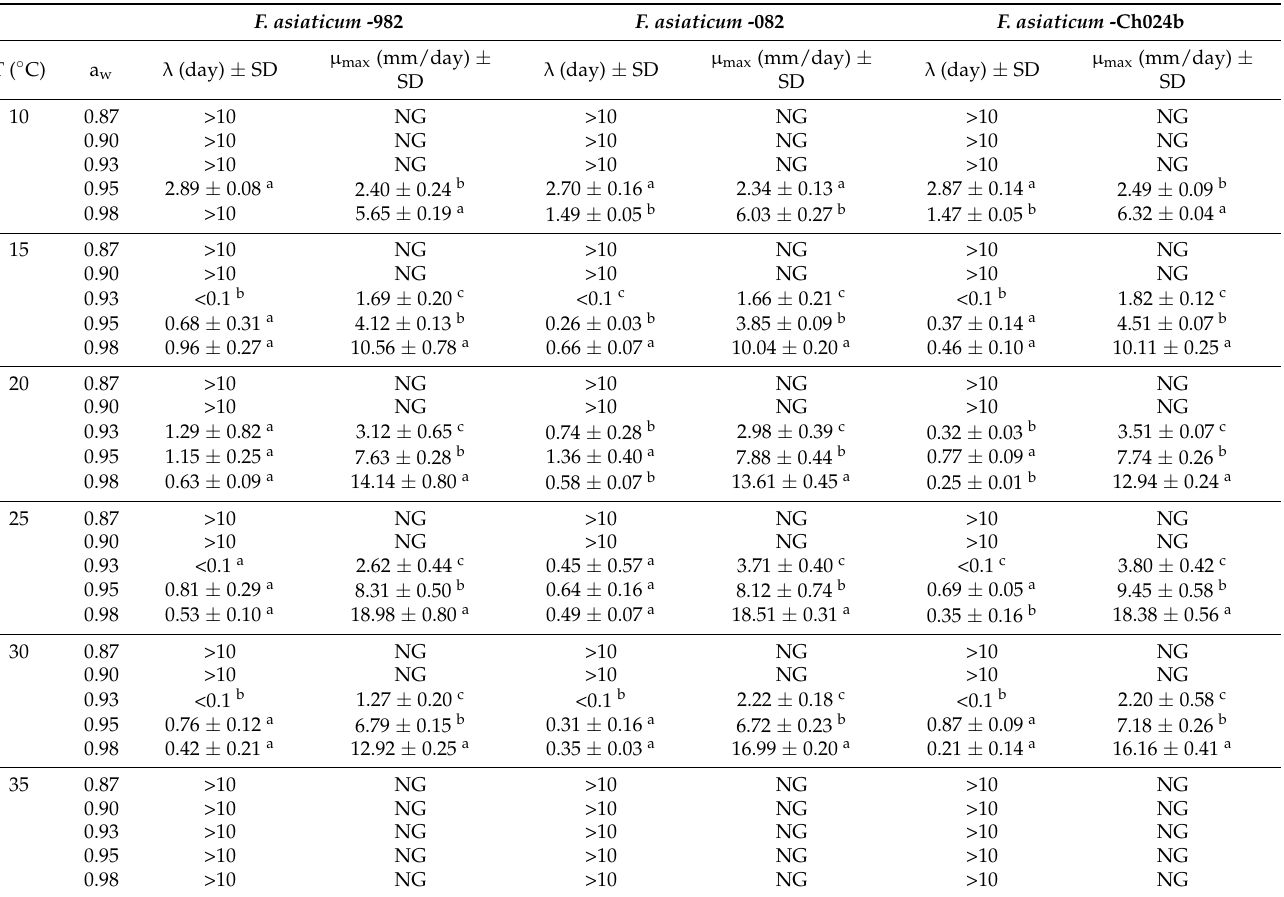
Table 2. Estimated maximum growth rate ( µ max ) and lag phase ( λ , days) of F. asiatiacum on wheat- based media under different a w × T conditions.